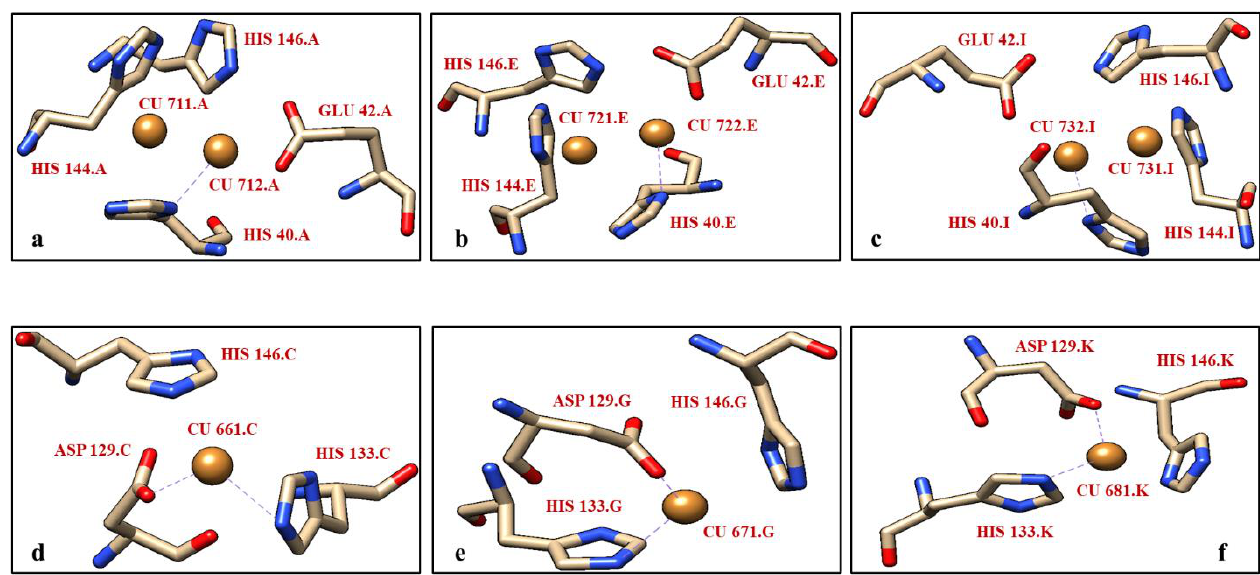
Figure 1. Arrangement of atoms in the pMMO of M. trichosporium OB3b. ( a ) Chain A having a dinuclear copper center with one free copper atom and bonded with H40, ( b , c ) Chain E and Chain I with the same arrangements as Chain A, ( d ) Chain C having a mononuclear copper center bonded with H133 and D120, and (e,f) Chain G and Chain K with the same arrangements as Chain C.